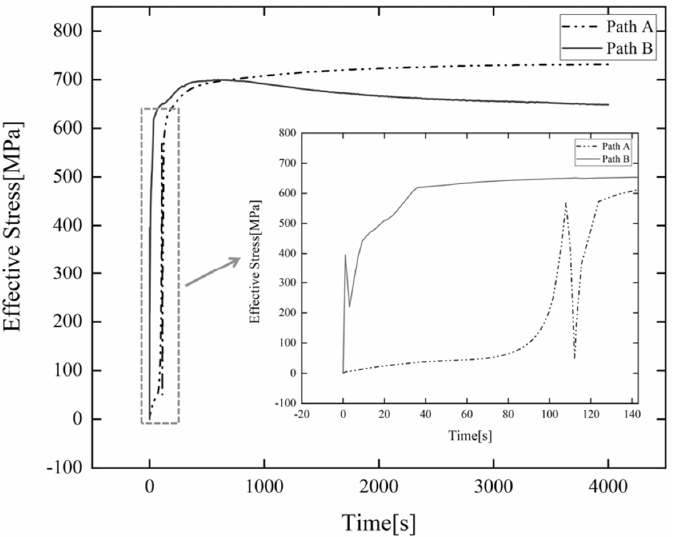
Figure 16. Variation of residual stress at the water outlet edge of the blade near the shroud.